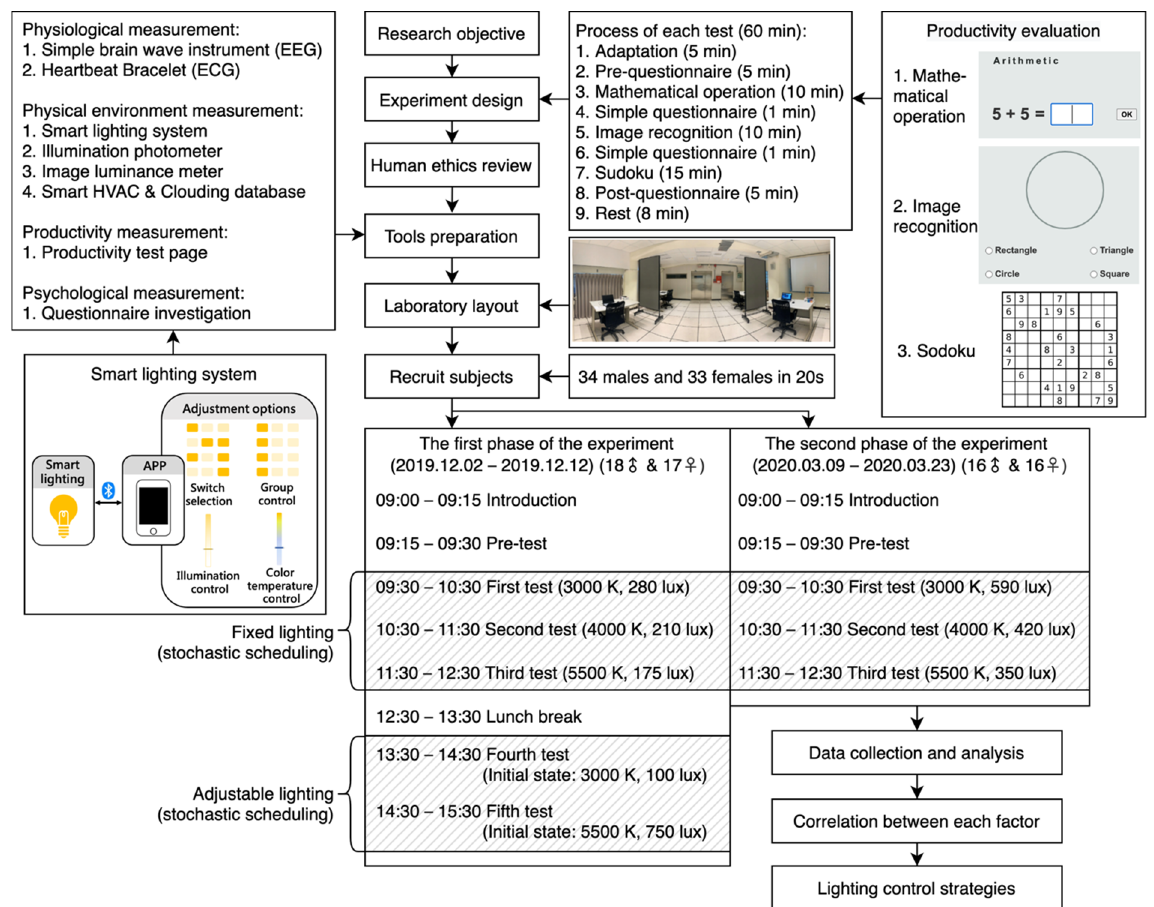
Figure 1. The complete research processes and details of the